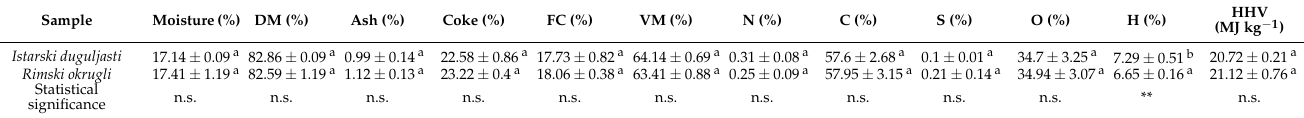
Table 2. Proximate, ultimate, and calorimetric analysis of natural